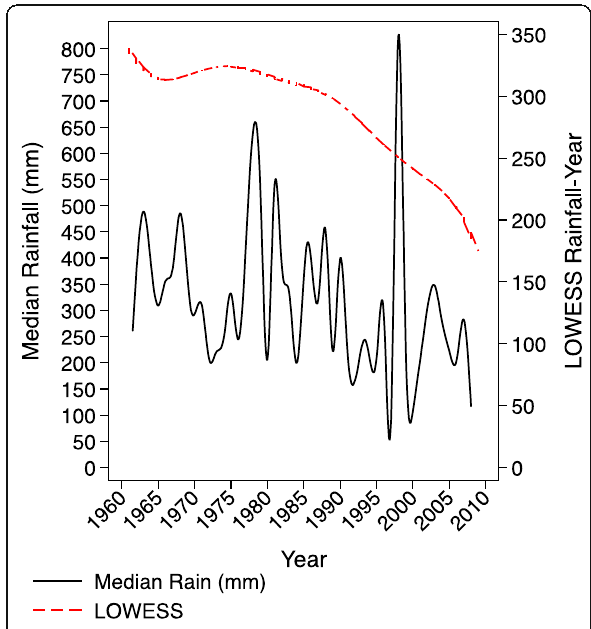
Figure 9 Median rainfall (mm) from 1960 to 2010. Superimposed on the plot in red is a LOWESS regression curve of rainfall against year. Note that this graph contains two separate axes: one for median annual rainfall and one for LOWESS smoothed annual rainfall. LOWESS is a polynomial smoothing technique that fits weighted least squares linear regression lines to localized subsets of data to describe deterministic variation in the data point by point. The power of this technique is that it takes into account neighbouring points of each point in determining the fit and repeats the entire